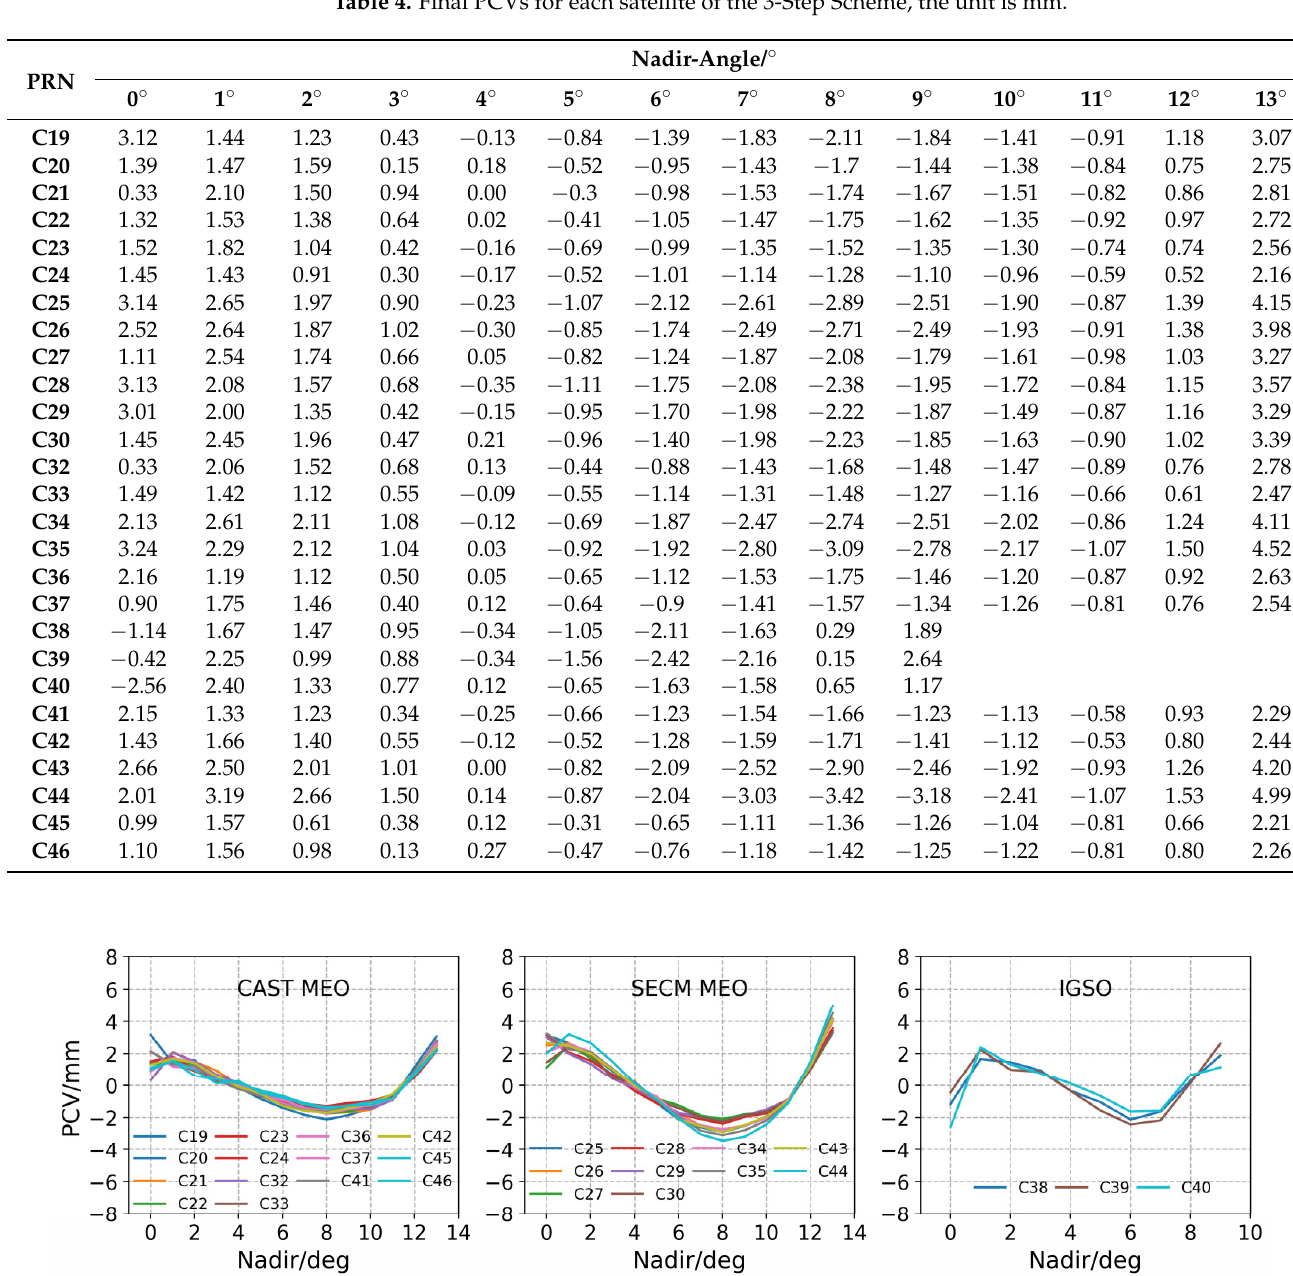
Table 4. Final PCVs for each satellite of the 3-Step Scheme, the unit is mm.